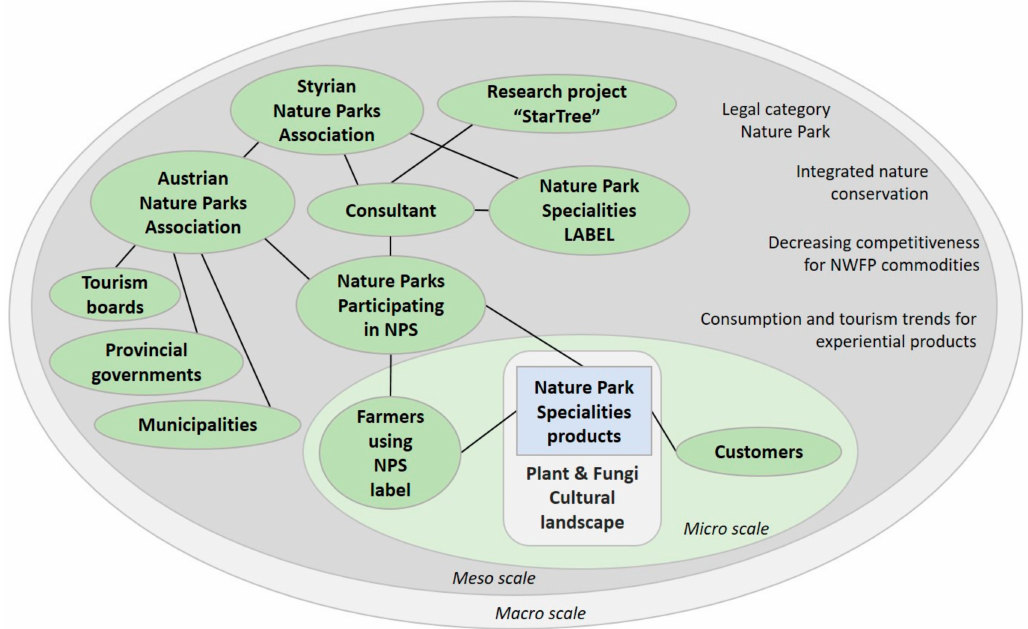
Figure 3. Actor network and context of the “Nature Park Specialities” (NPS) label. NWFP: non-wood forest